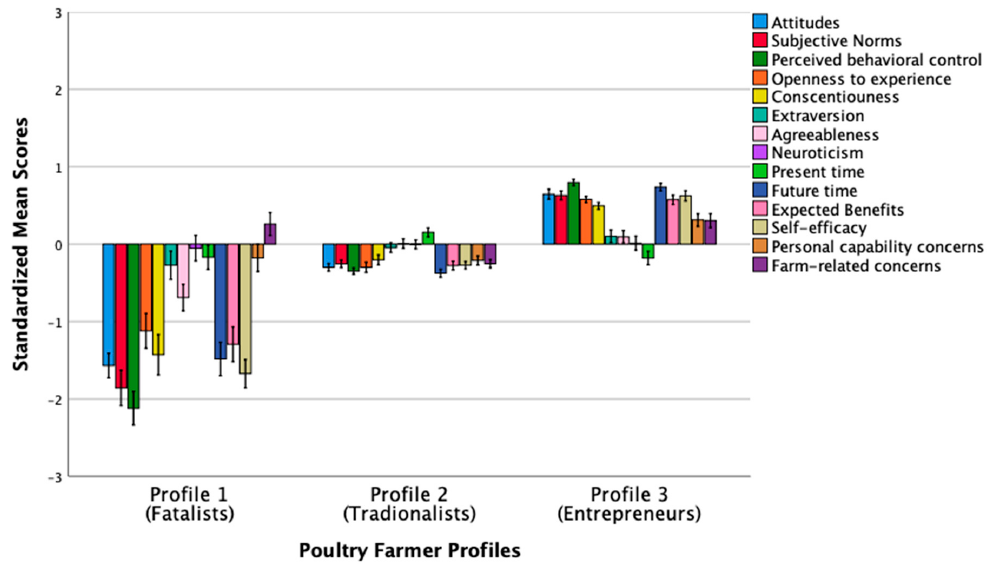
Figure 3. Profile of poultry farmers (Profile 1, n = 26; Profile 2, n = 230; Profile 3, n = 170; Reprinted with permission from [9]. 2023. Bhullar et al.